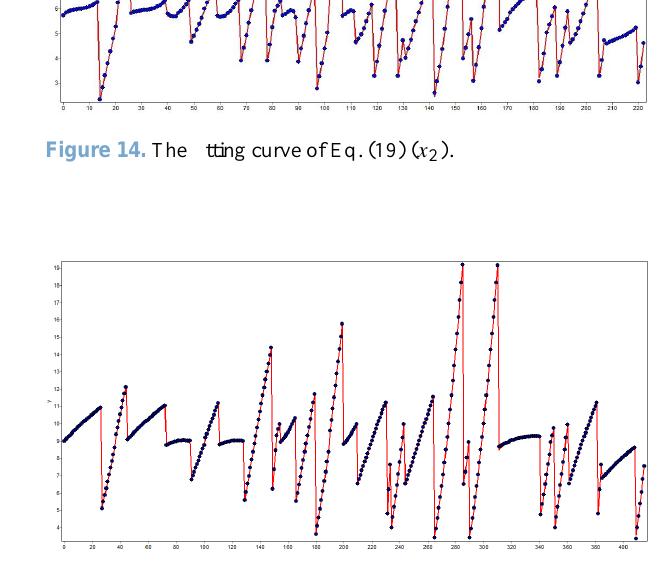
Figure 15. The fitting curve of Eq. (20) ( x 3